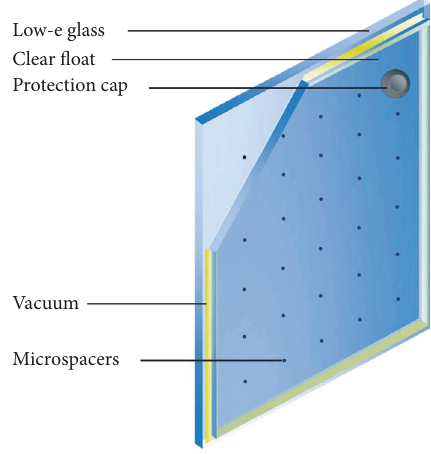
Figure 1: Vacuum glazing (Pilkington